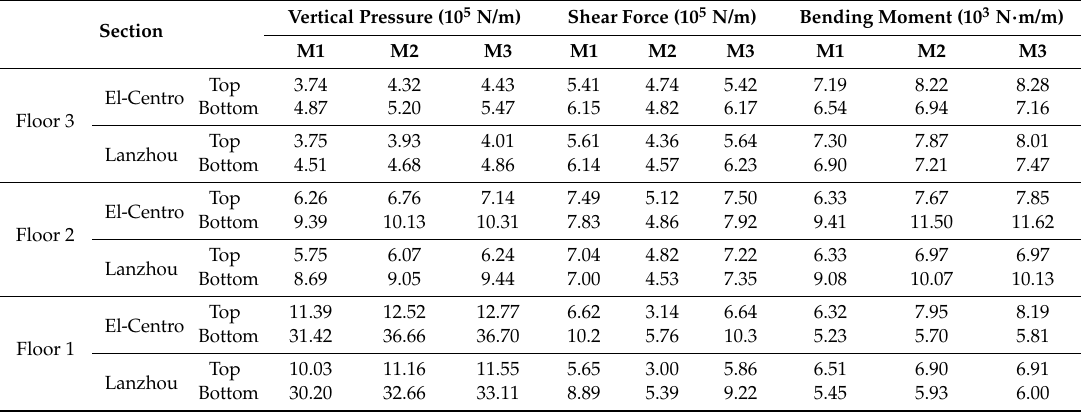
Figure 18. The peak internal forces of surface-6 under El-Centro motion. The following can be concluded from Figure 18 and Table 5: (1) Different input motions have different influences on the internal force of side walls. The shear forces of components are similar between horizontal direction motion and coupling input motion. Furthermore, the vertical pressure and bending moments of components under vertical seismic motion are similar to those in coupling input motion. Oblique incidence motion makes the vertical pressure and bending moments increase obviously. (2) In comparing the peak value of internal force in different sections, it can be seen that the shear force and vertical pressure of the bottom of the side wall on the third floor are, at most, about 1.03 × 106 N/m and 3.67 × 106 N/m respectively, values which are significantly greater than those on the other floors. So, the bottom of the side walls is the seismic weak part of the structure. (3) The bending moments at joint parts of the side wall on the second floor are larger than the rest of the structure, because the extra inertia force caused by the electrical equipment leads to the second floor being in a complex bend torsion condition. The bending moments of the second floor under coupling seismic action increase by 20% compared to those under horizontal